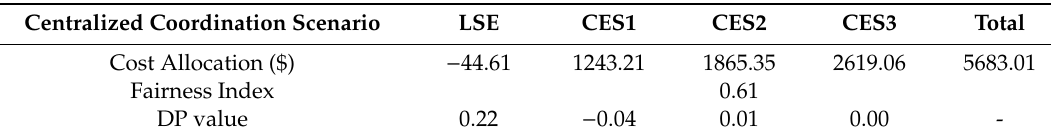
Table 3. The cost allocation scheme based on cooperation.